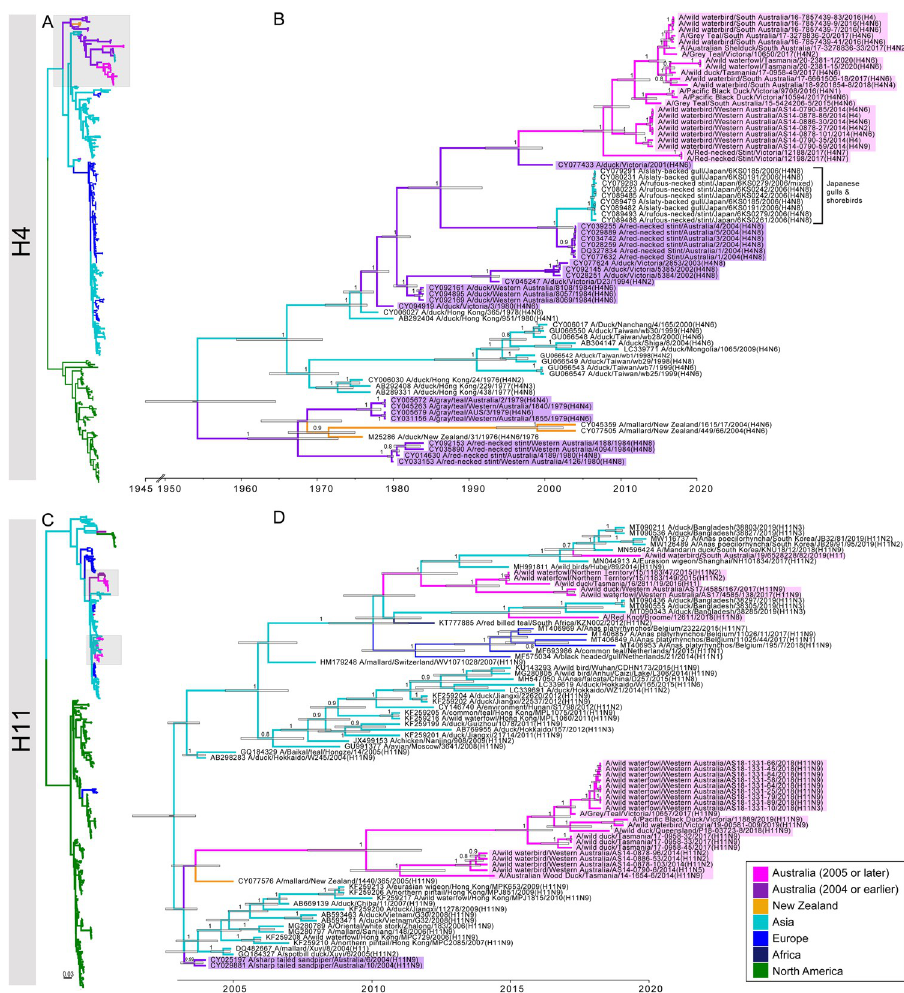
Fig 3. Phylogenetic trees of subtypes H4 and H11. (A, C) Phylogenetic trees comprising global diversity. Branches of reference sequences are coloured by continent. Sequences from Australia are coloured in pink (2005 and later) and in purple (pre-2005), with 2005 marking the year of the oldest sequence in the data set generated in this study. (B, D) Time structured phylogenetic trees. The trees comprise Australian lineages (as indicated by grey boxes in A, C) and closest relatives (retrieved by BLAST searches). Branches are coloured by year and geography as above. Branch labels correspond to posterior clade probabilities of each node, node bars correspond to the 95% HPD of node height. We selected H4 as it is the only HA subtype for which there is clear introduction of an Australian lineage virus into Asia (indicated in square parenthesis), and is an example of an HA segment for which there is only a single contemporary lineage. We selected H11 as it is the subtype with the largest number of contemporary Australian lineages (4), of which 2 are represented by a single sequence. Trees for all other HA subtypes can be found in S4–S15 Figs.